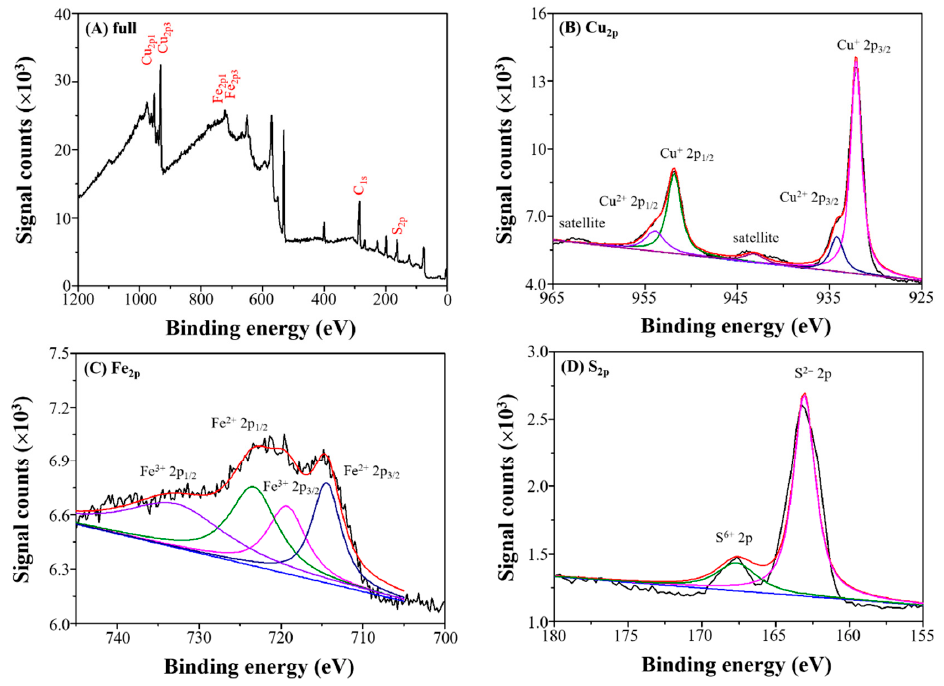
Figure 7. XPS spectra of CuFeS 2 : ( A ) full scan; ( B ) Cu 2p ; ( C ) Fe 2p ; and ( D ) S 2p . Deconvolution of XPS peaks for Cu 2p , Fe 2p and S 2p elements represented in different color line.